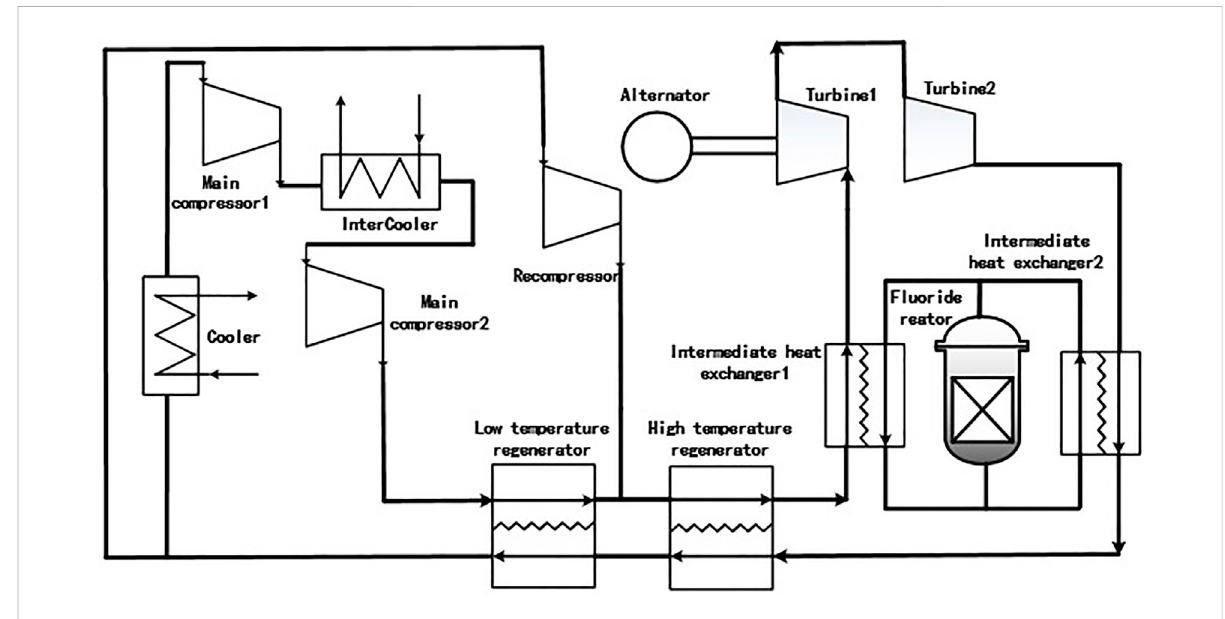
FIGURE 9 Flow chart of the reheat recompression intermediate cooling cycle.